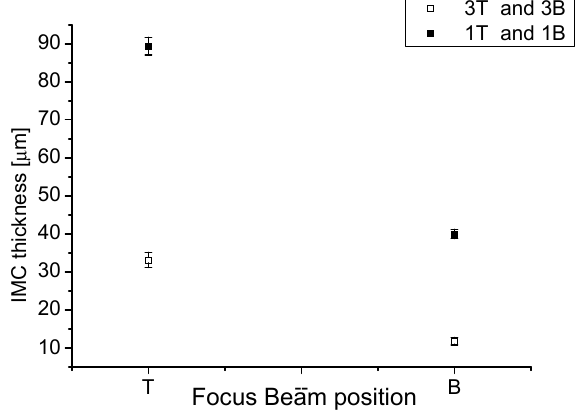
Figure 4. IMCL thickness size for joints 1T and 1B and joints 3T and 3B as function of the focus beam position.